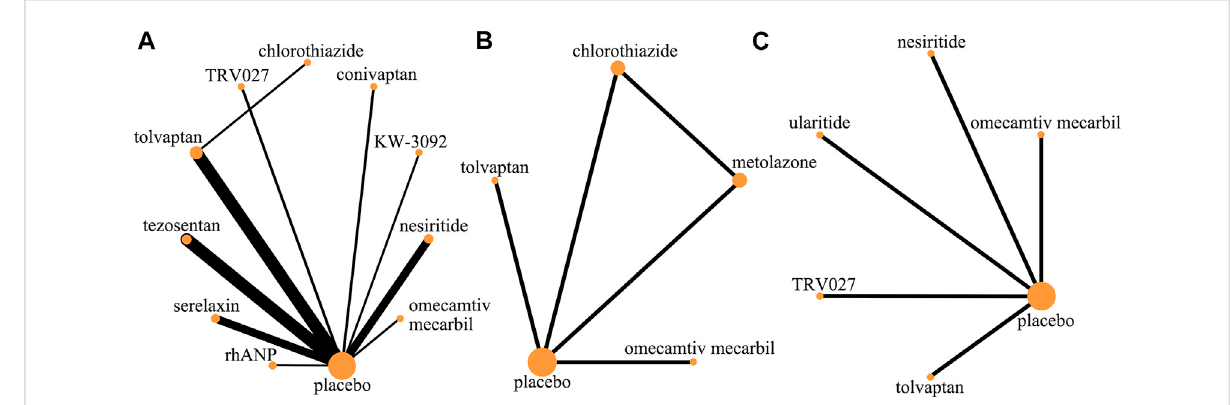
FIGURE 2 Evidence network (death and rehospitalization). (A) All-cause mortality within 30 days; (B) all-cause readmission rate within 30 days; (C) HF- related readmission rate within 30